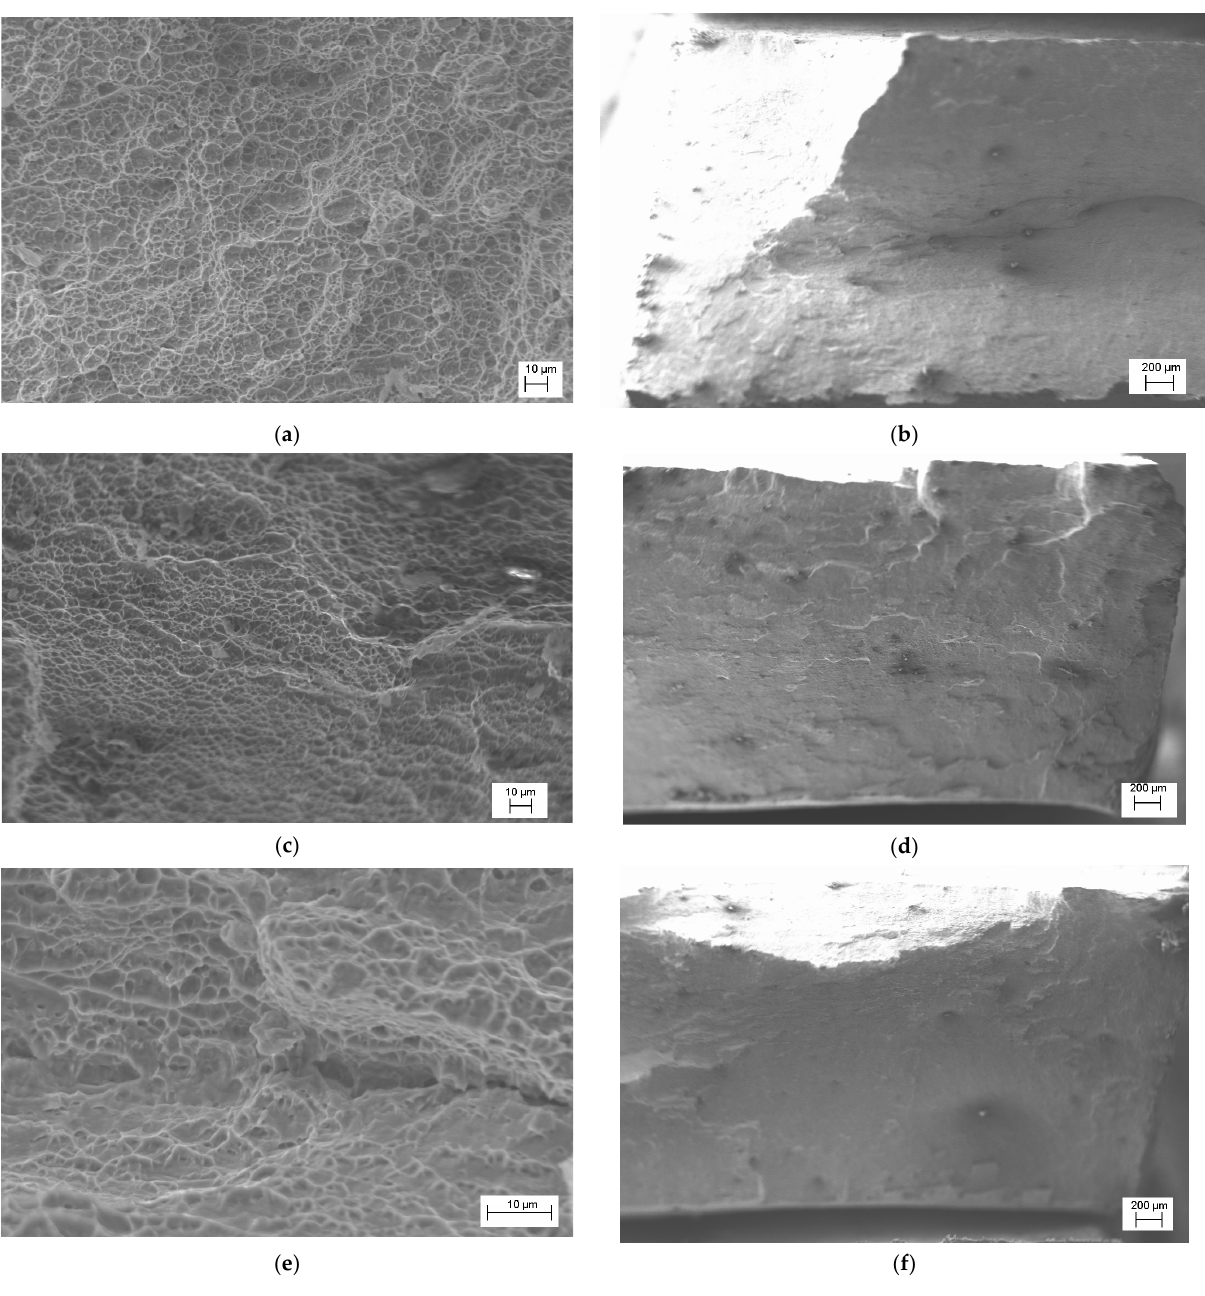
Figure 5. Fracture micromechanisms of specimens from titanium alloy VT23 rolled in the transverse direction after the DNP and subsequent static tensioning: ( a , b )— ε і mp = 0.81%; ( c , d )— ε і mp = 2.56%; ( e , f )— ε і mp = 4.56%.